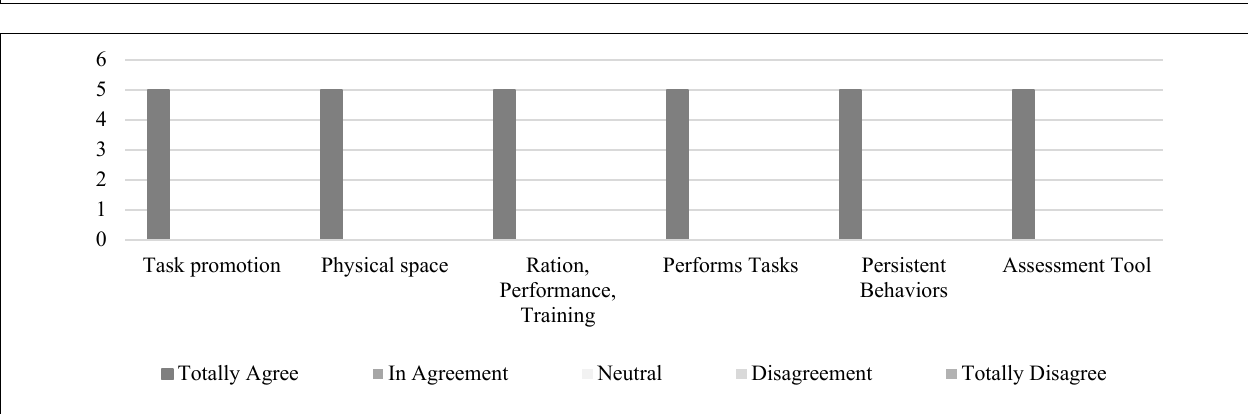
FIGURE 6 | Automation of programmatic contents by competencies.